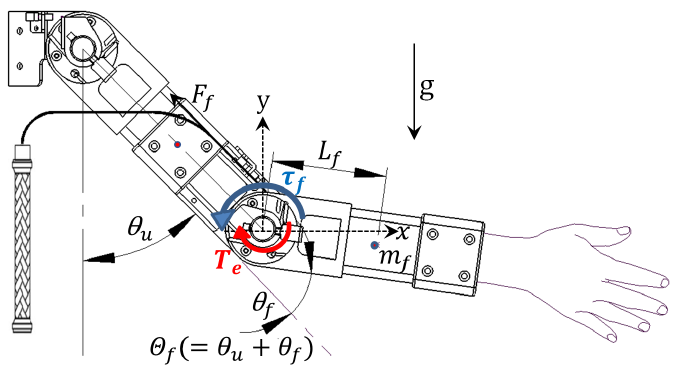
Figure 10. Dynamic model of the elbow joint of the designed WURAES.